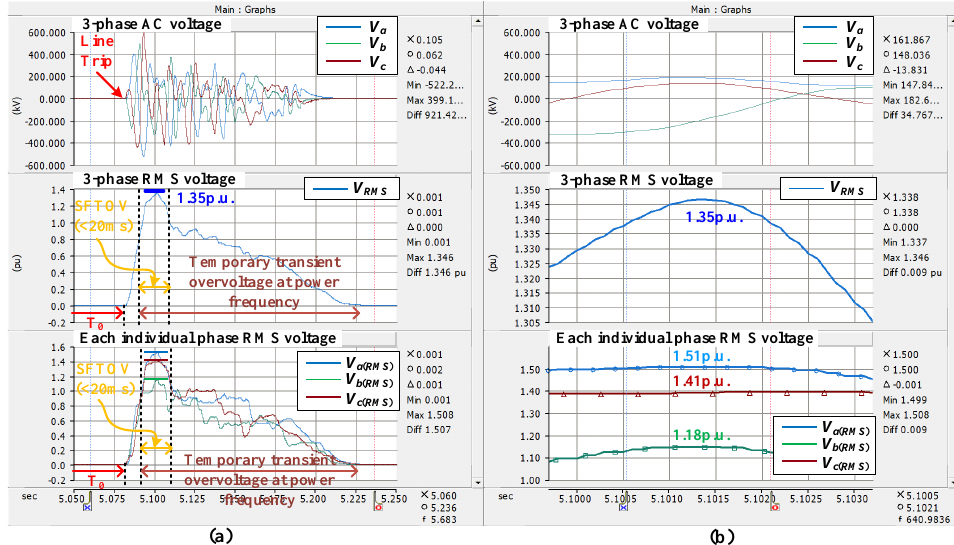
Figure 14. PSCAD/EMTDC simulation results for comparison of single phase RMS value. ( a ) Zoomed-out results and ( b ) zoomed-in